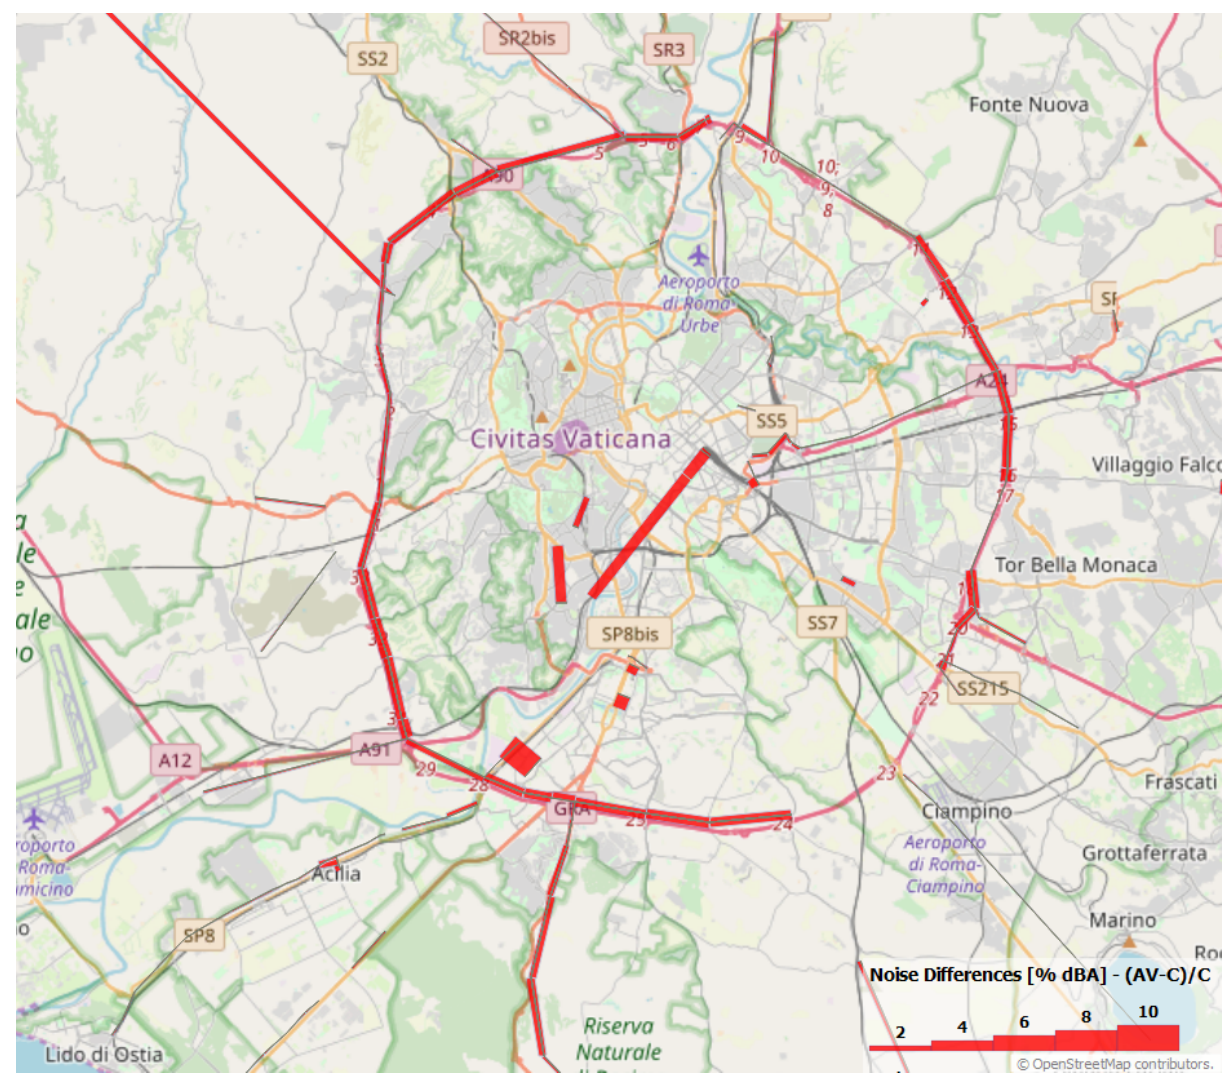
Figure 5: Noise pollution comparison: positive relative difference (100% AVs emissions are higher than current scenario)